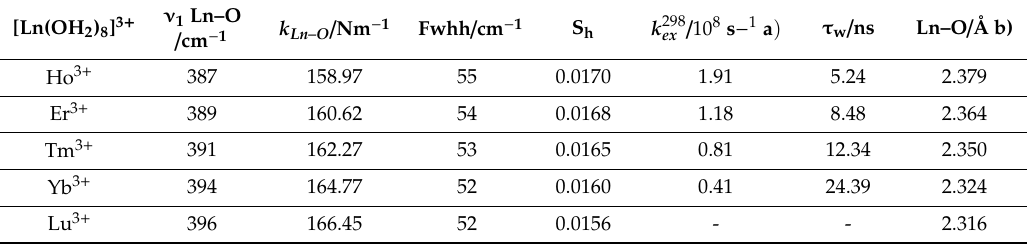
Table 1. Band parameters such as peak positions, ν 1 , force constants , k Ln–O , the full width at half heights, and the scattering intensities for the Ln–O breathing mode of Ho 3 + , Er 3 + , Tm 3 + , Yb 3 + and Lu 3 + for the [Ln(OH 2 ) 8 ] 3 + species at 22 ◦ C. Furthermore, the literature data for the water exchange [24] and the Ln–O bond distances [7] for these [Ln(OH 2 ) 8 ] 3 + species are